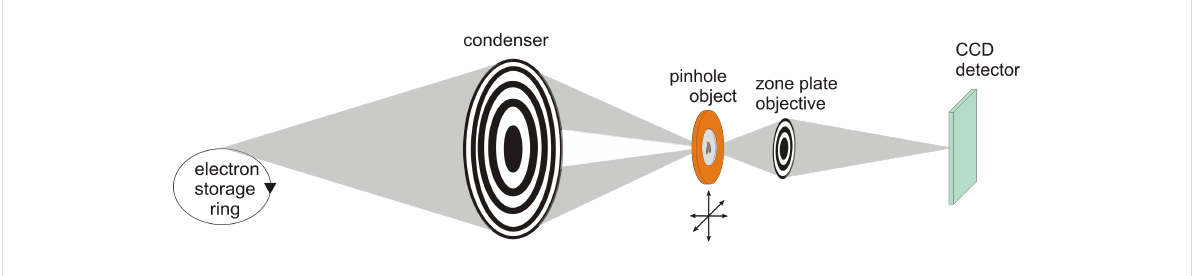
Figure 4: A full field transmission X-ray microscope (TXM) for a bending magnet source uses two zone plate lenses, condenser and objective, to form a 2D image on the detector. Additionally, a pinhole close to the sample is necessary which acts together with the condenser as a monochromator.